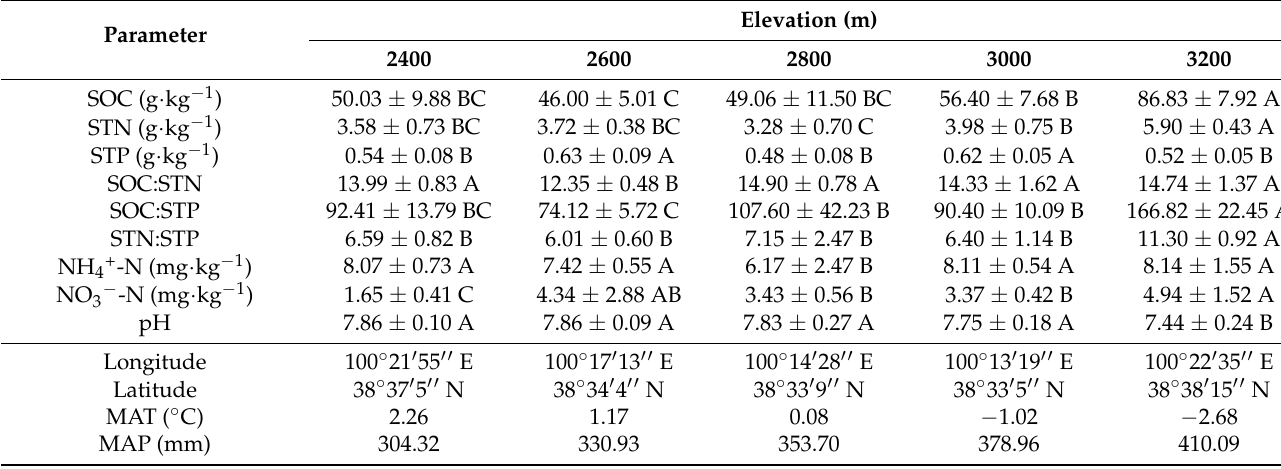
Table 2. Soil nutrient contents, mean annual temperature and mean annual precipitation across the elevational gradient within the study area.